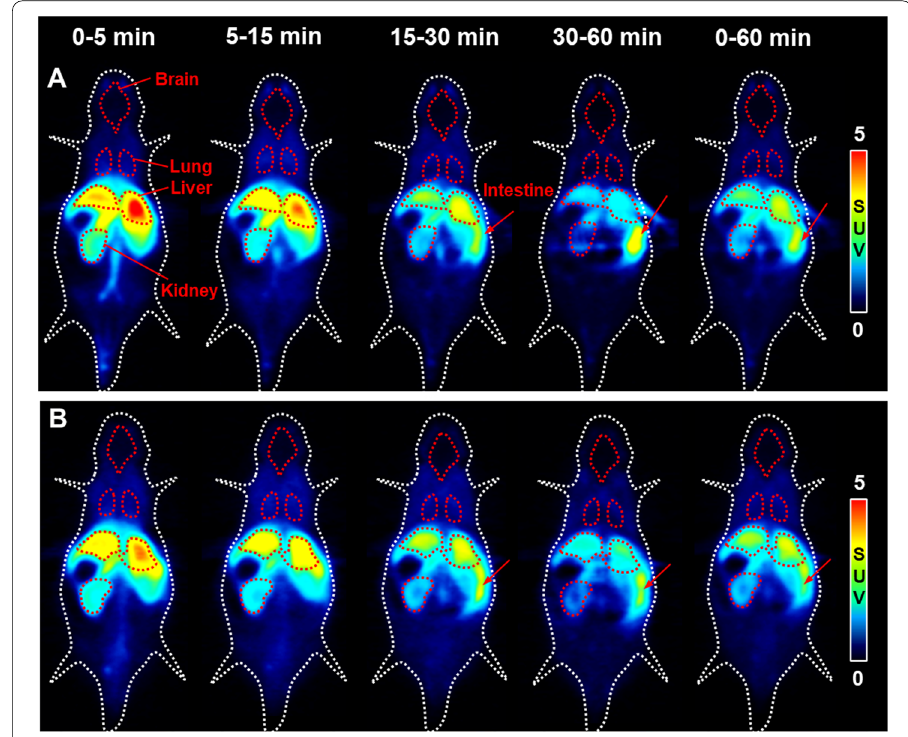
Small‑animal PET imaging using